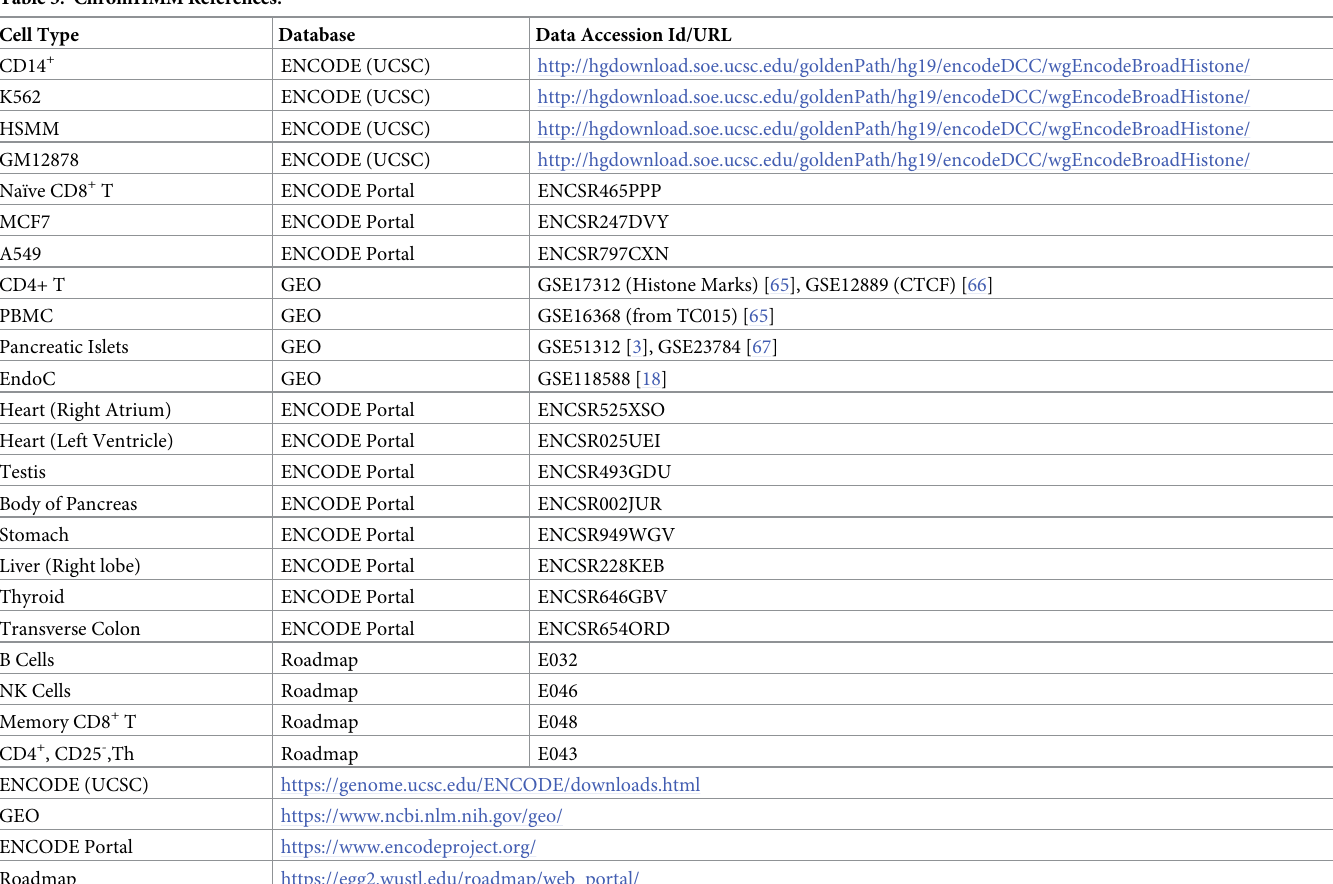
Table 3. ChromHMM